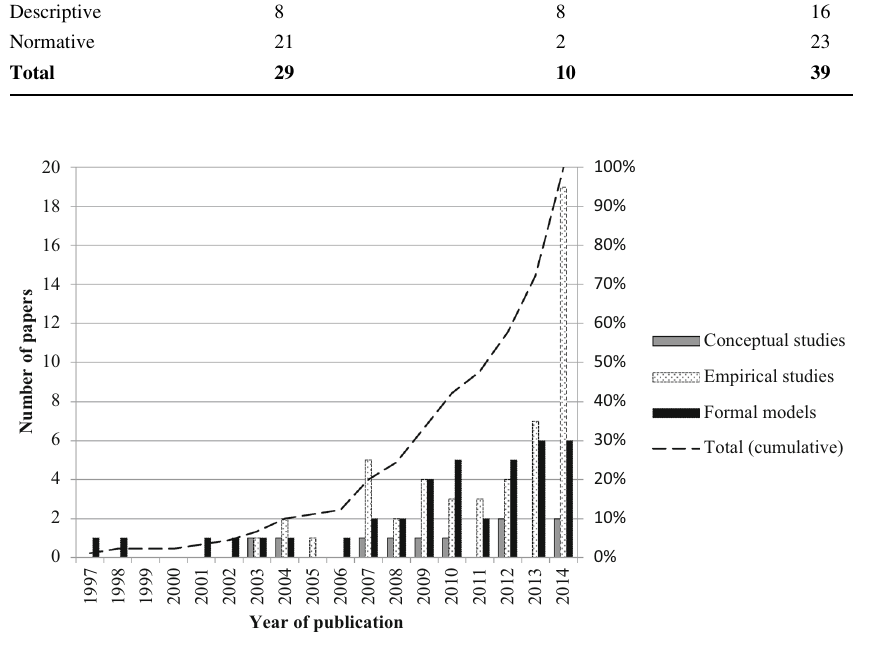
Fig. 1 Distribution of sample papers over